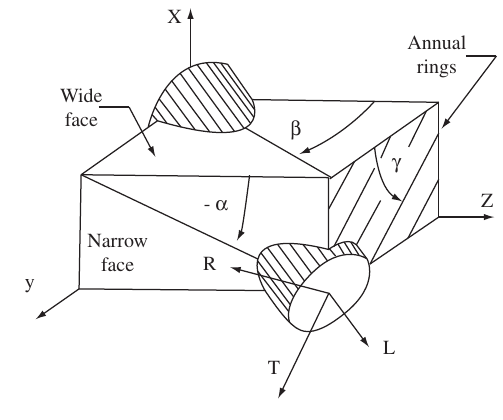
Figure 7. Surface angles a , b and